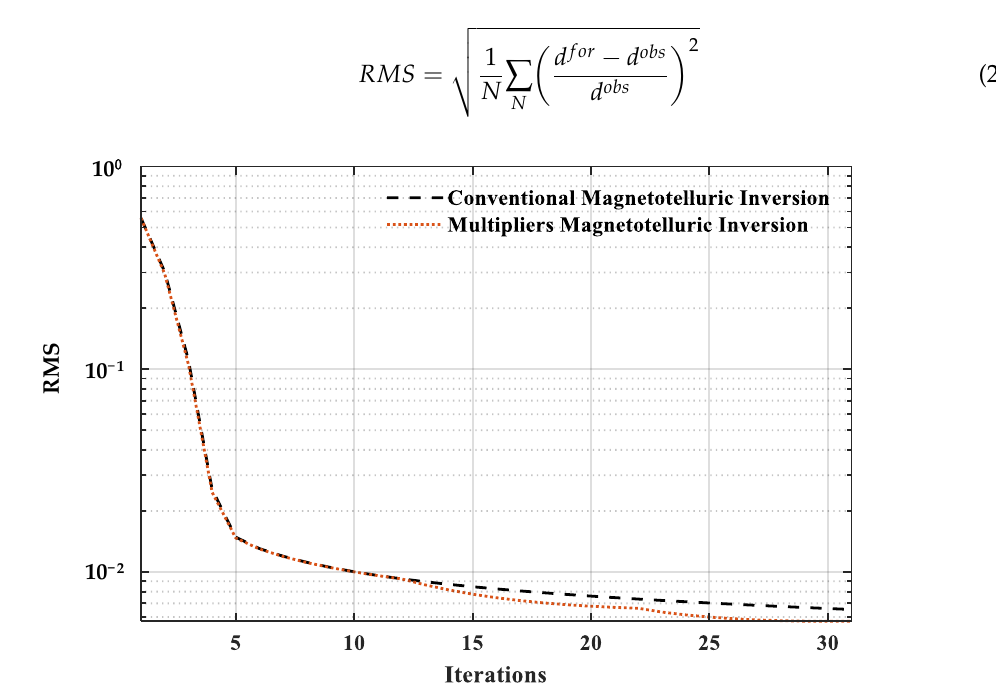
Figure 3. Comparison of RMS data fitting error curves. Table 1. Model error, RMS data fitting error, and inversion time for the heave model.